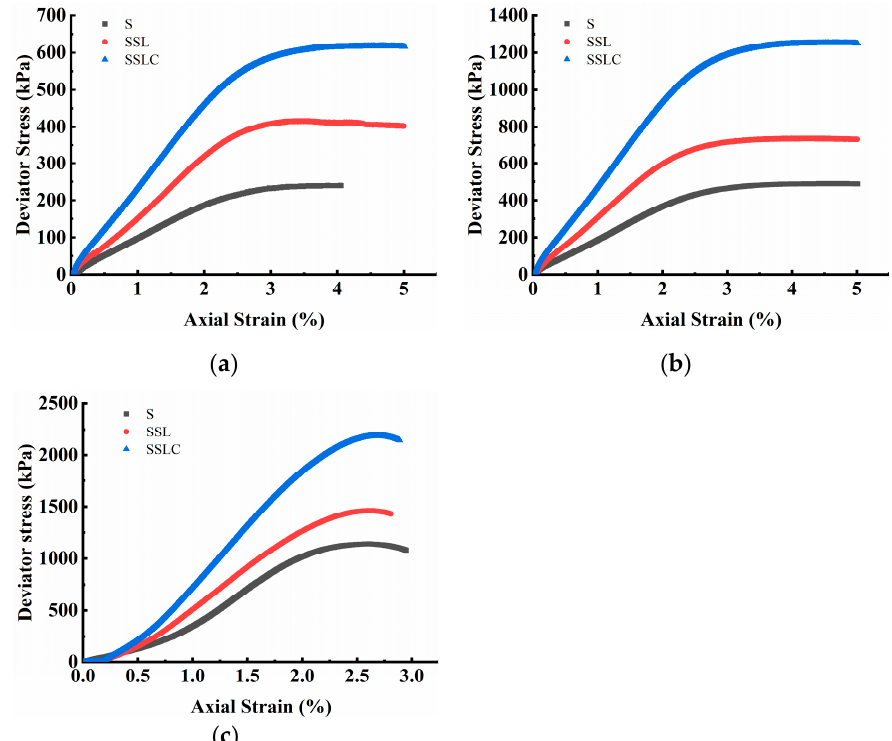
Figure 9. The stress-strain curves at different confining pressures: ( a ) 50 MPa; ( b ) 100 MPa; ( c ) 200 MPa.